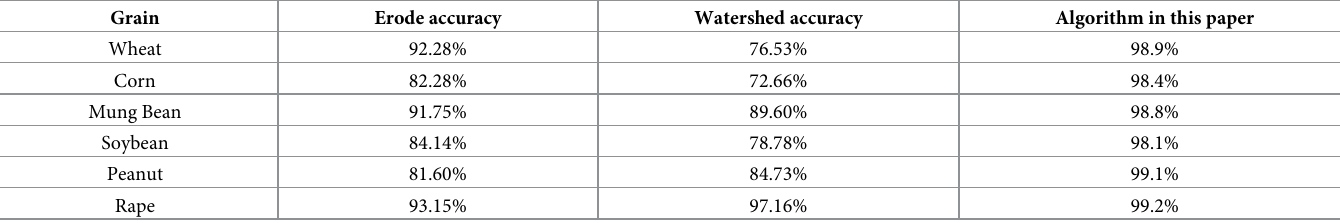
Table 4. Algorithm accuracy